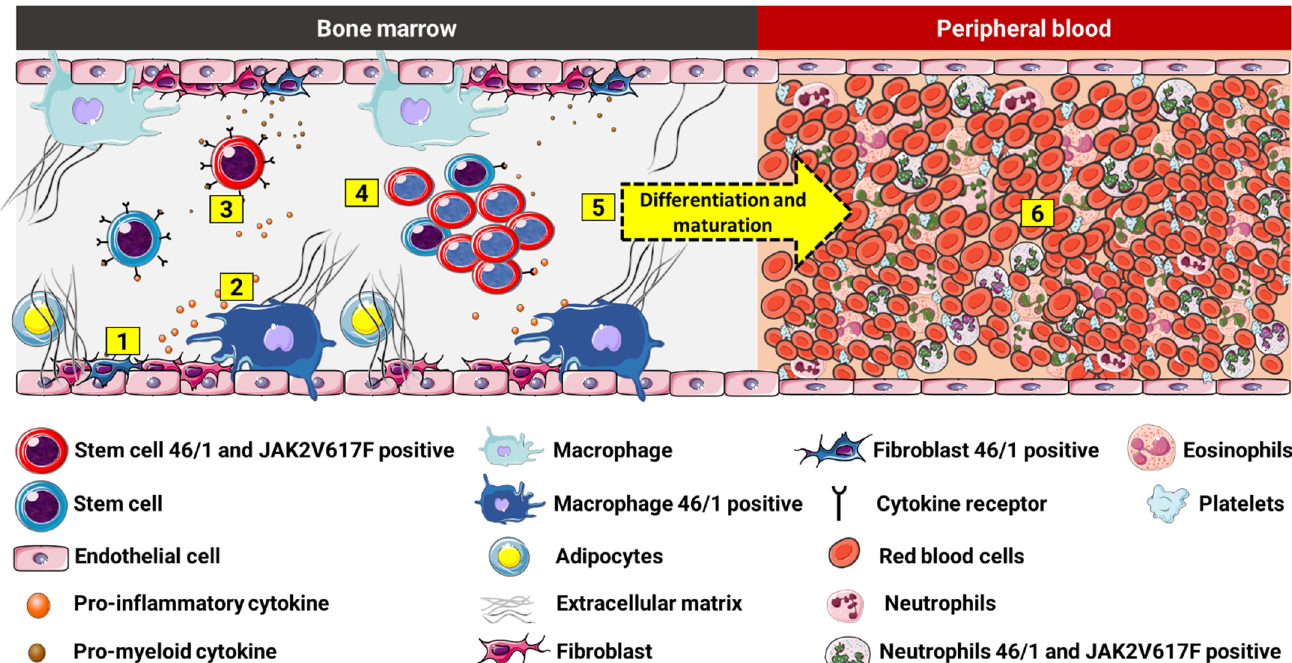
Figure 5. Possible association of the 46/1 haplotype and MPNs. (1) Medullary stromal cells positive for 46/1 may show dysregulation in genes, such as INSL4 and INSL6 , which may be involved in the (2) excessive production of proinflammatory and promyeloid mediators. These cytokines (3) interact with normal and haplotype-positive and JAK2V617F multipotent stem cells, promoting (4) exac- erbated proliferation (proliferative advantage) of the mutated cells, which, in turn, continue their process of (5) differentiation and cell maturation, and trigger the (6) clonal myeloproliferative